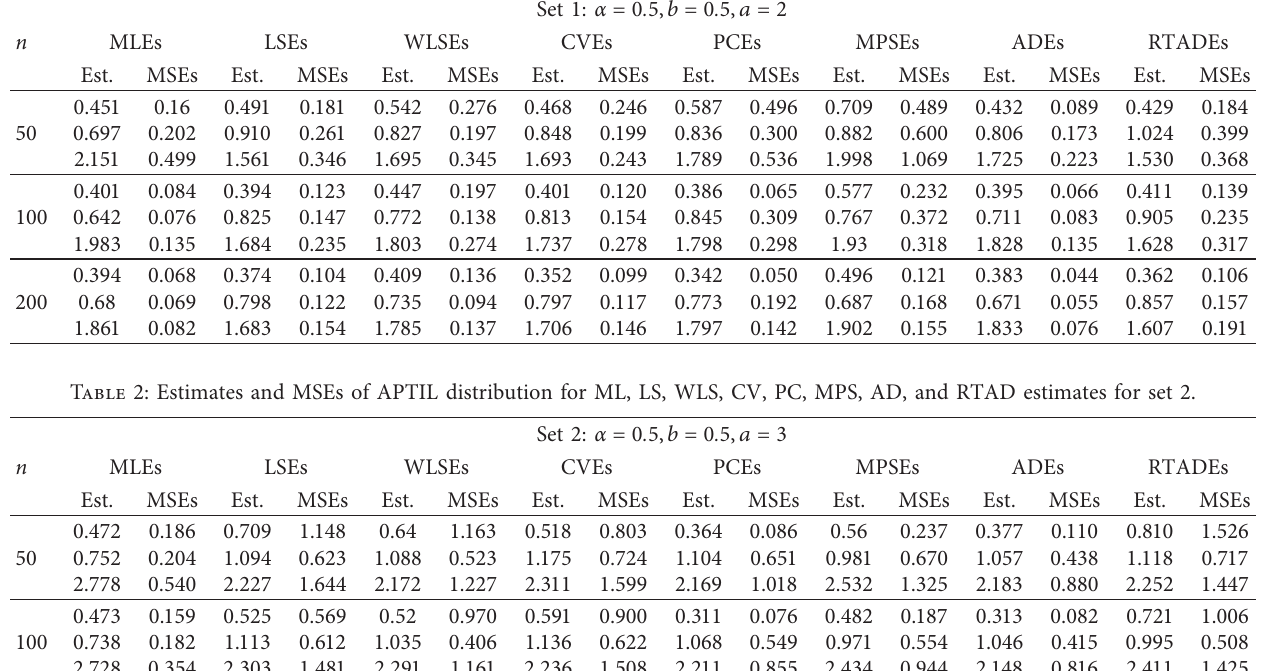
Table 1: Estimates and MSEs of APTIL distribution for ML, LS, WLS, CV, PC, MPS, AD, and RTAD estimates for set 1. n